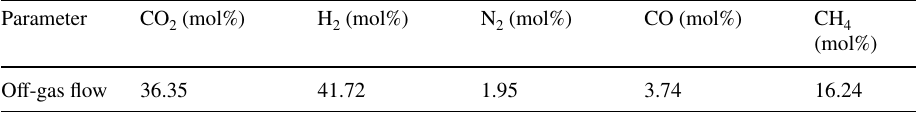
Table 1 Chemical composition of the ICIIC off-gas